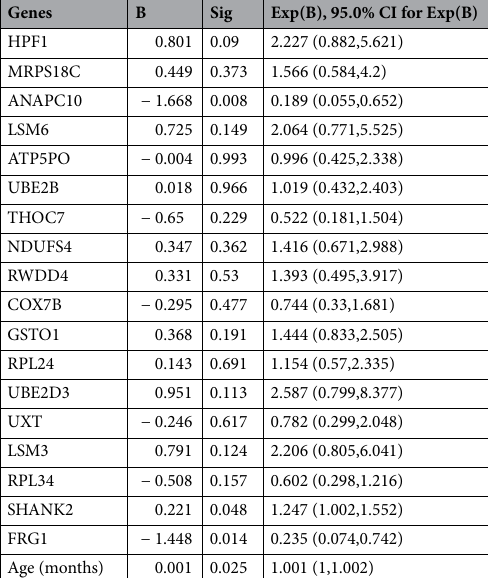
Table 2. Covariates present in multivariate Cox regression model in lung cancer